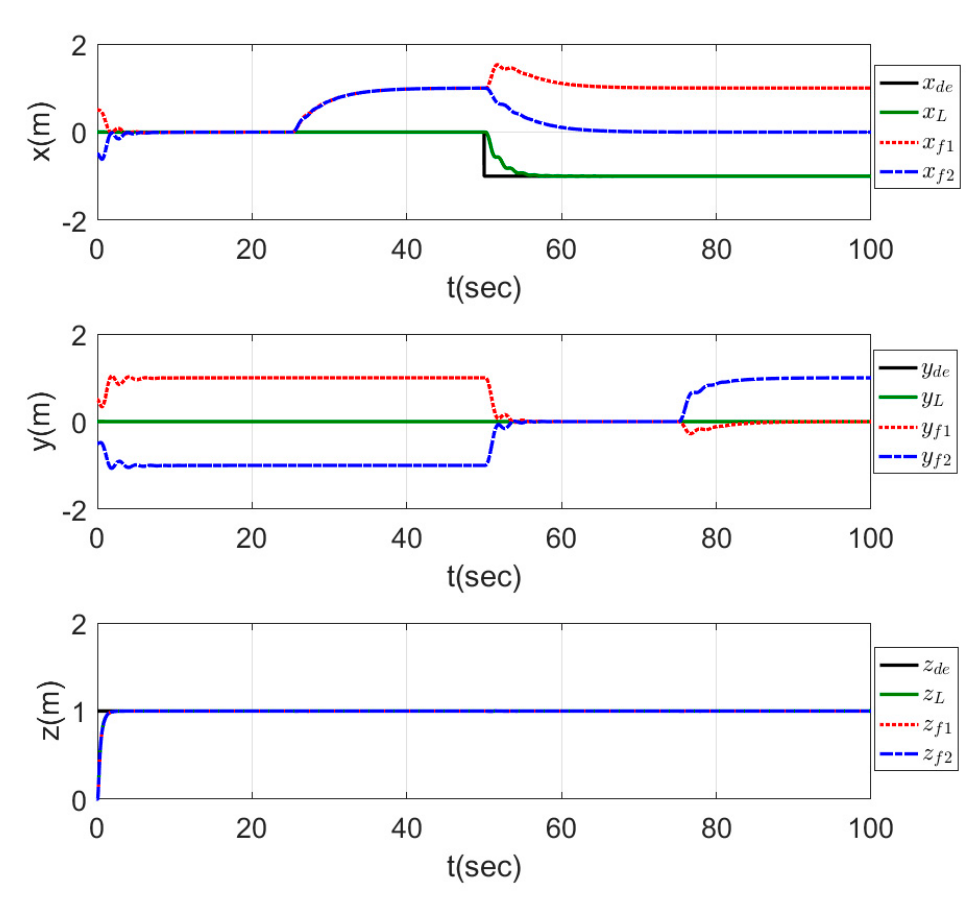
Figure 18. Time response of switching formation topology.